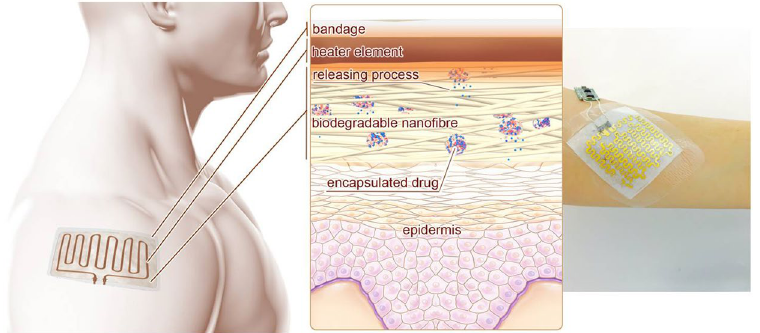
Figure 1. The principle of operation of the drug delivery system and a typical fabricated bandage with integrated heater and electronics. Thermo-responsive drug nanocarriers were embedded within nanofibers of the engineered mesh and released their payload upon temperature increase induced by the integrated flexible heater. A typical fabricated bandage with the miniaturized control electronics is shown on the